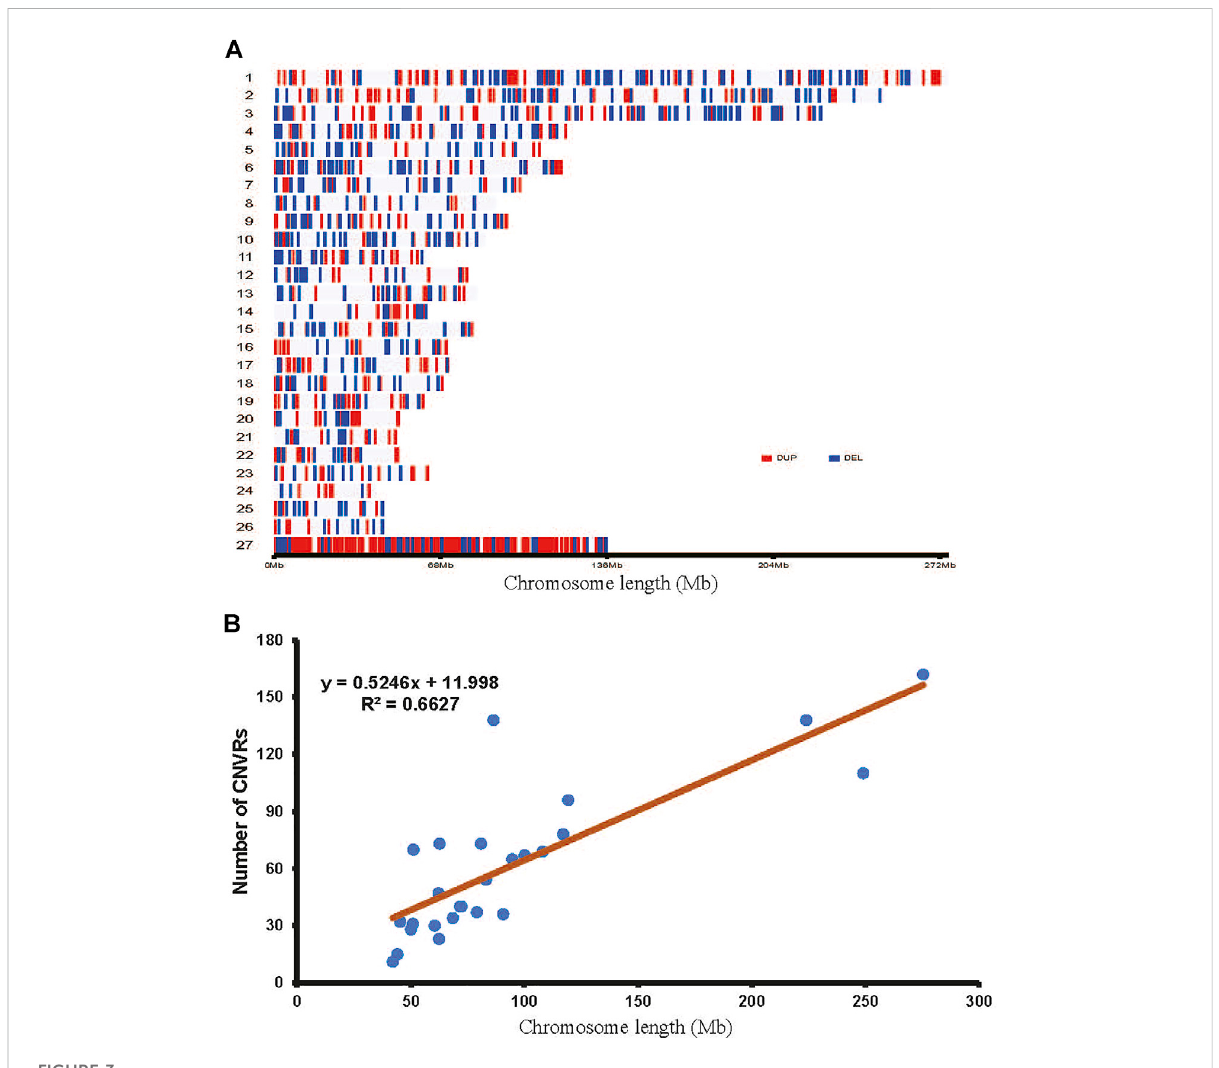
FIGURE 3 Genomic landscape of CNVRs in Tibetan sheep.